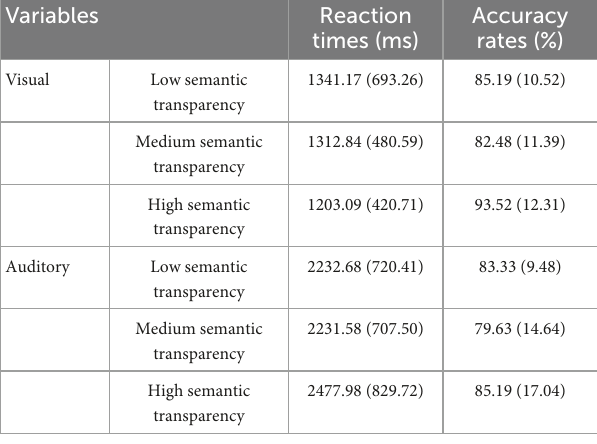
TABLE 3 Reaction times and accuracy rates in each condition of the semantic transparency experiment.